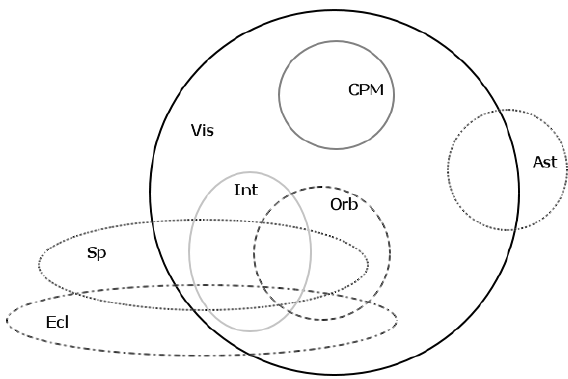
Fig. 1. Possible interference between major observational classes of binary